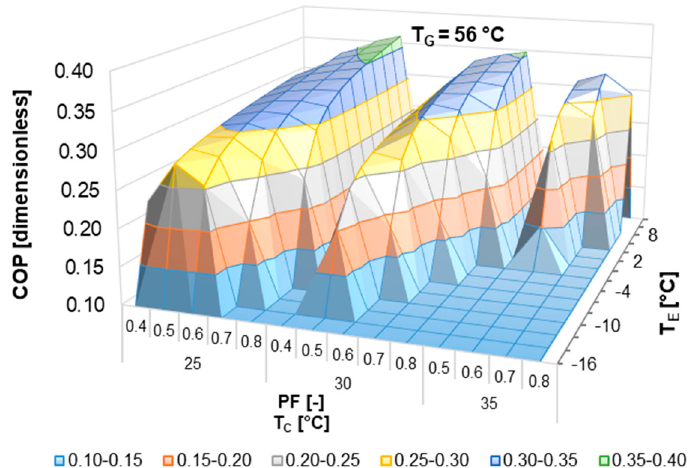
Figure 13. COP of the half-effect cycle against PF and T E for different T C . Analyzed case: T G = 56 °C.